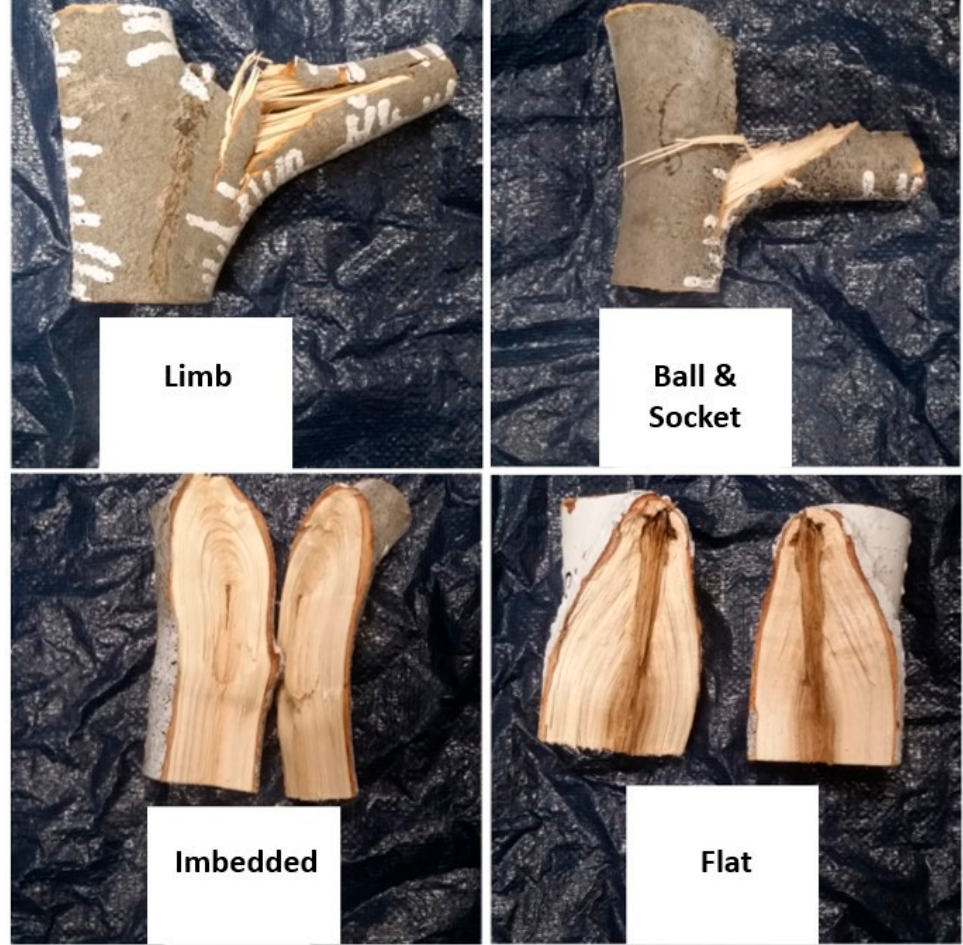
Figure 4. Example of failure modes: branch, ball and socket, imbedded, and flat. To evaluate strain patterns and differences in attachment zones, maximum strain was transformed using Log 10 to adjust for normality and labeled Log 10 (MaxStrain). The percentage of maximum strain for each failure mode was calculated by dividing the mean strain for each branch zone by the mean maximum strain of the seven zones for the given failure mode. Proc Ttest and Proc GLM with Tukey HSD were used for means analysis. Exploratory multiple linear regression analysis regressing Log 10 (MaxStrain) on a suite of branch union variables (aspect ratio, separation angle, initial angle, branch length, and